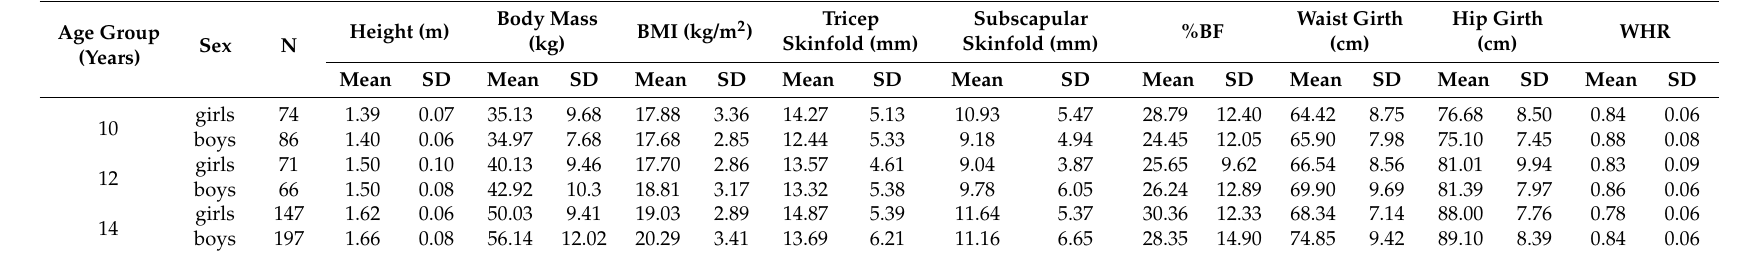
Table 1. Descriptive statistics for anthropometric measurements.